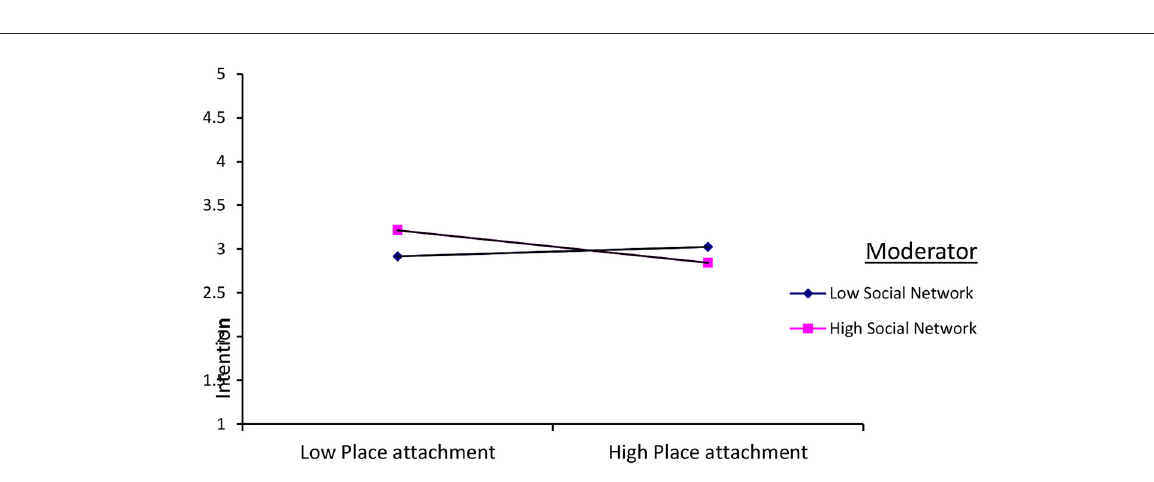
FIGURE4 The plot of the interaction effect of place attachment and social network on intention to